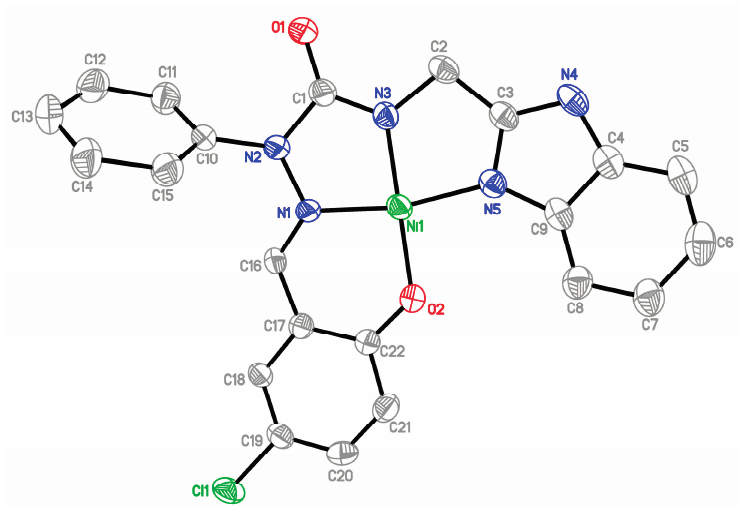
Figure 6. ORTEP drawing of Ni complex of 5-chlorosalicylaldehyde 2-phenyl-4-[(1 H -